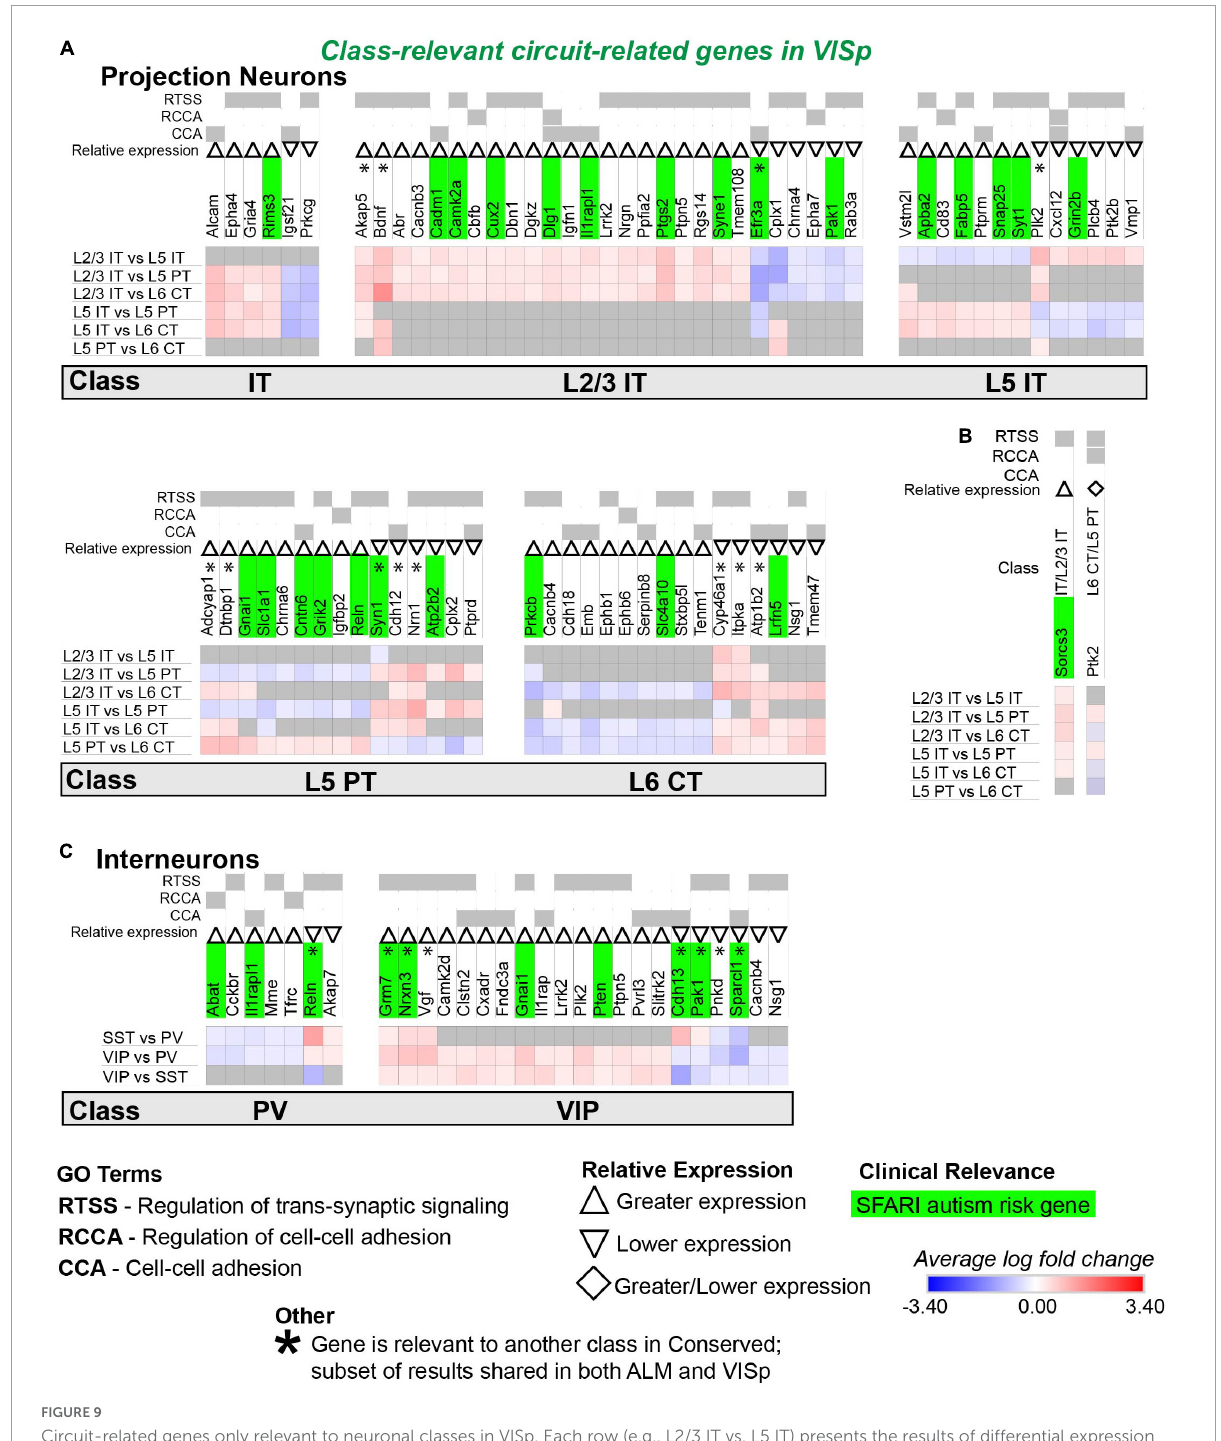
FIGURE9 Circuit-related genes only relevant to neuronal classes in VISp. Each row (e.g., L2/3 IT vs. L5 IT) presents the results of differential expression tests between neuronal classes. Differential expression results are always relative to the first neuronal class in a comparison (e.g., L2/3 IT in ‘L2/3 IT vs. L5 IT’). Gray indicates no significance in differential expression. Shades of red and blue indicate the log fold change of average expression for tests that were statistically significant. Up and down arrows denote whether expression was higher or lower relative to the other classes. (A) Circuit-related genes relevant to single classes of excitatory projection neurons. We created the new class “IT” for genes that were relevant to both L2/3 IT and L5 IT classes. (B) Circuit-related genes relevant to multiple classes of excitatory projection neurons. The diamond symbol indicates that a gene is relevant to two different classes: it is equivalent to an up arrow for the first gene and a down arrow for the second. For example, and the L6 CT class has greater expression of Ptk2 relative to the other classes, and the L5 PT class has lower expression relative to the other classes. (C) Circuit-related genes relevant to single classes of inhibitory interneurons. CCA = cell-cell adhesion; RCCA = regulation of cell-cell adhesion; RTSS = regulation of trans-synaptic